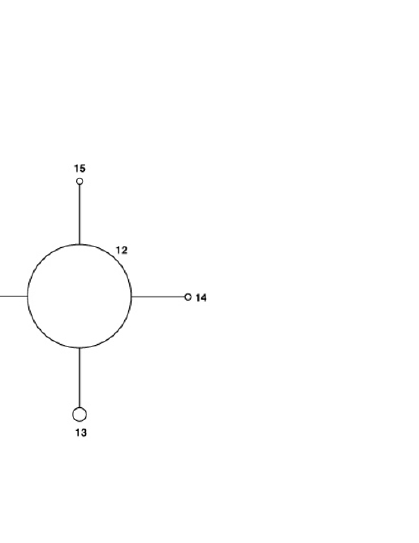
Figure 4 Minimum spanning tree relating inferred haplotypes. Each numbered node (circle) represents a haplotype, and the area of the node represents the haplotype's frequency. Edges (lines between nodes) represent nucleotide differences. Each edge repre- sents one nucleotide difference unless indicated otherwise in parentheses. Ch = chimpanzee, Go =